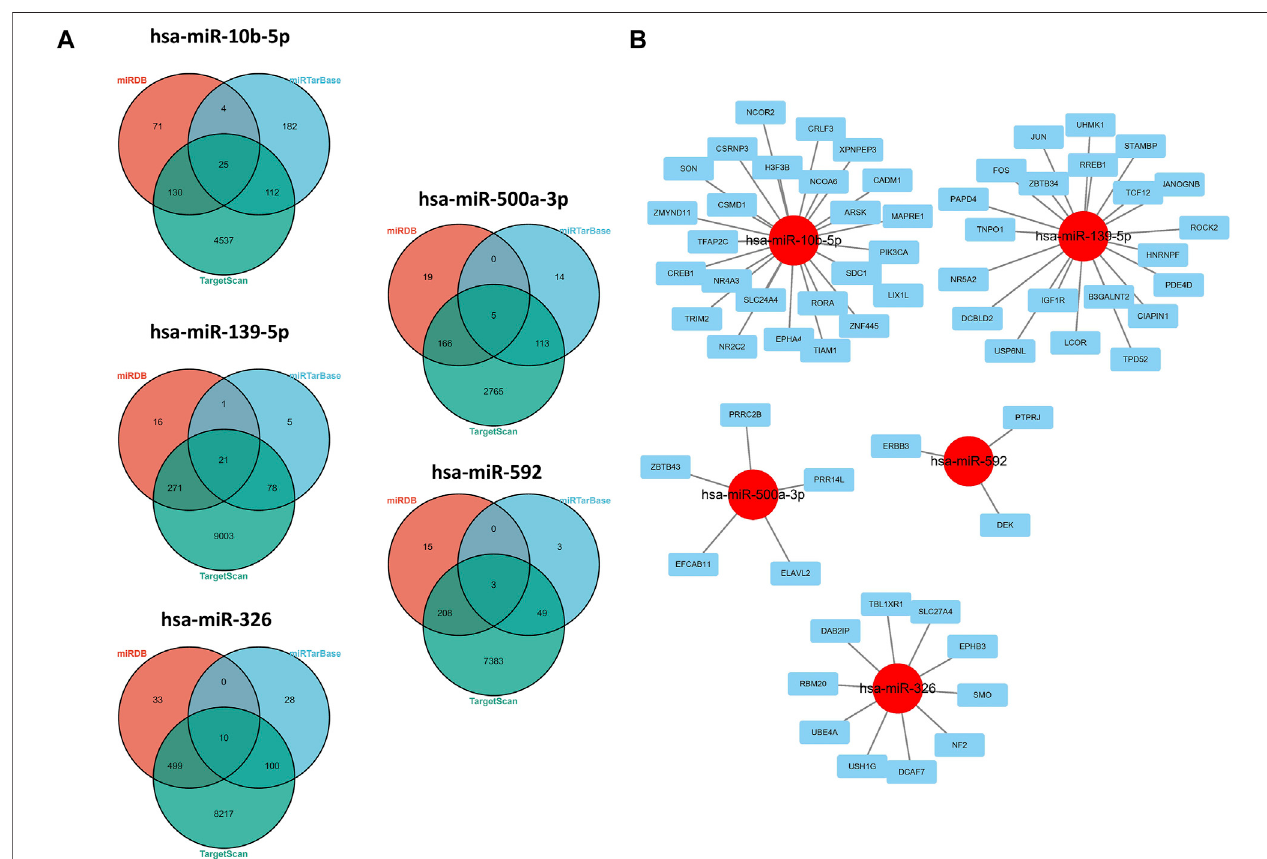
FIGURE 5 | Regulatory network of 5-miRNAs. (A) Venn plots in three databases. (B) Regulatory network conducted by Cytoscape